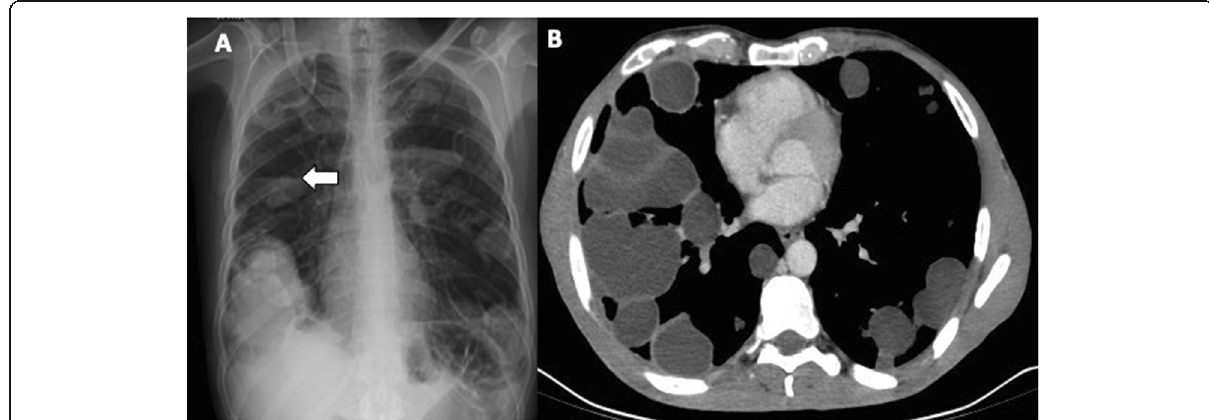
Fig. 12 A 50-year-old man with hepatic and pleuro-pulmonary echinococcosis, secondary to trans-diaphragmatic dissemination. a Chest x-ray shows bilaterally multiple round cavitated lesions — some of which with air-fluid level (arrow) — as well as radiopaque lesions. b Chest CT scan of